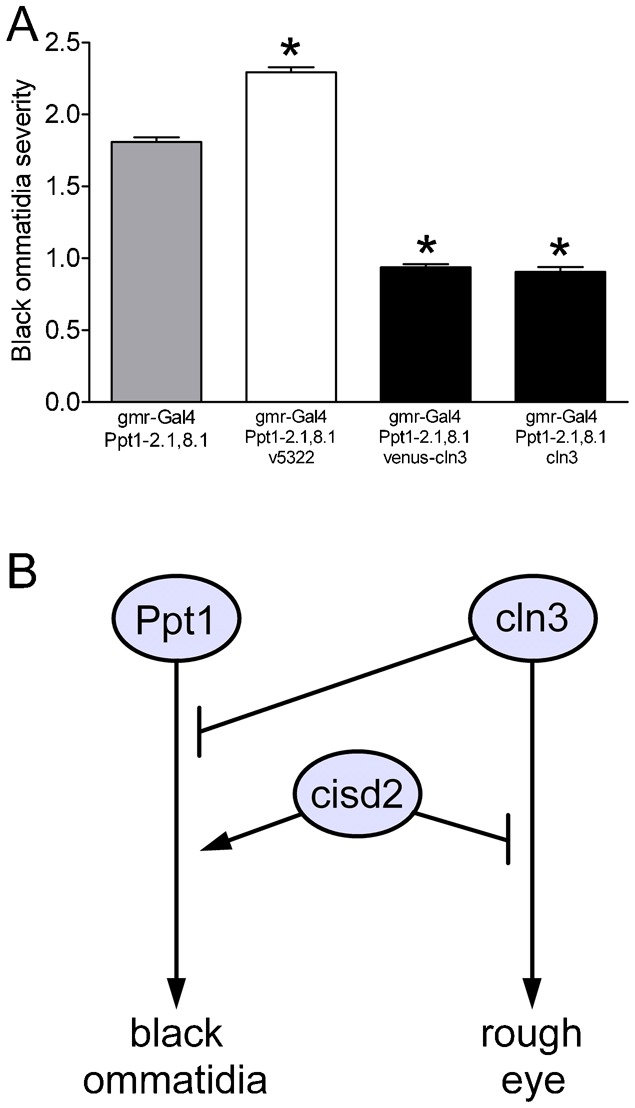
Genetic interaction between Ppt1 and cln3 and a proposed genetic model for cisd2, Ppt1 and cln3 function.(A) The severity of black ommatidia due to Ppt1 overexpression (grey bar, gmr-Gal4/Ppt1-2.1,8.1) was enhanced by cln3 RNAi (white bar, gmr-Gal4/Ppt1-2.1,8.1/v5532) and suppressed by cln3 overexpression (black bars, gmr-Gal4/Ppt1-2.1,8.1/venus-cln3 and gmr-Gal4/Ppt1-2.1,8.1/cln3) (Kruskal–Wallis ANOVA, p<0.0001; *Dunn's multiple comparison tests, p<0.001; n = 178–666/genotype). Data are compiled from two independent experiments. (B) Genetic model for cisd2, Ppt1 and cln3. Overexpression of Ppt1 and cln3 led to eyes that had black ommatidia or were rough, respectively. cisd2 is a positive regulator of the Ppt1 pathway and a negative regulator of the cln3 pathway. cln3 is a negative regulator of the Ppt1 pathway. Arrows in the model could represent the function of multiple genes and are not meant to indicate direct physical interactions between the gene products from cisd2, Ppt1 or cln3.